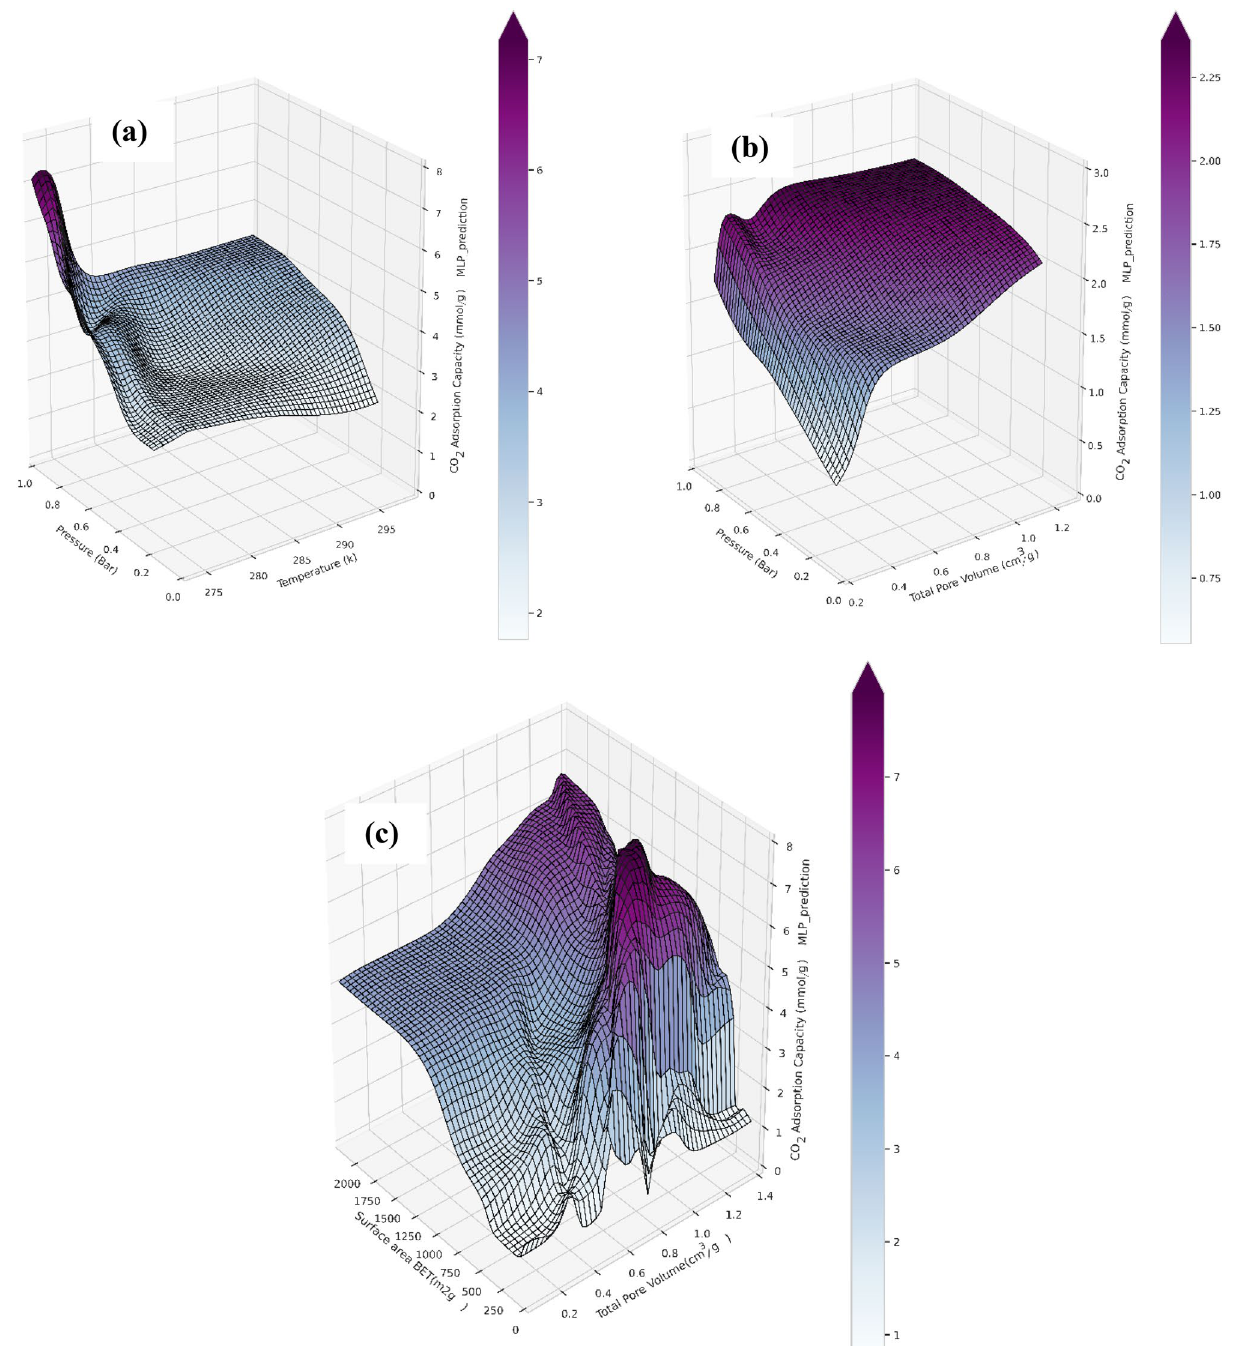
Figure 12. 3D response surface plots generated by ANN-MLP model: ( a ) temperature verus pressureat BET = 1500 and pore volume = 0.4 ( b ) pressure versus pore volume at T = 273 K and BET = 99.54 ( c ) BET versus pore volume at T = 303 K and P = 1